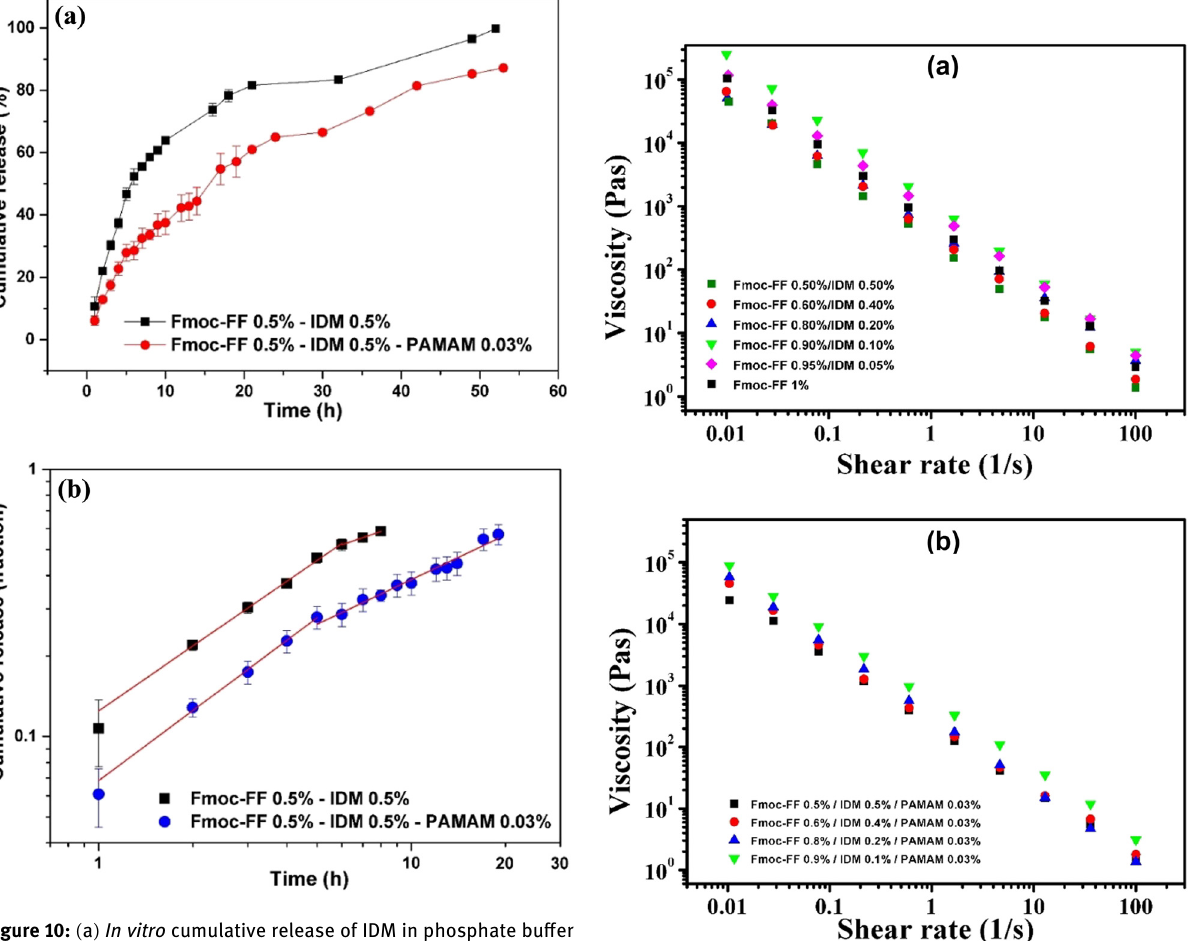
Figure 10: ( a ) In vitro cumulative release of IDM in phosphate bu ff er ( pH = 7.4 ) from IDM - loaded Fmoc - FF – PAMAM dendrimer hydrogels. ( Figure 11: ( a ) Steady shear viscosity as a function of shear rate for ( a ) Fmoc - FF – IDM hydrogels with varying IDM content and ( b ) Fmoc - FF – IDM – PAMAM hydrogels with varying IDM content and fi xed PAMAM concentration of